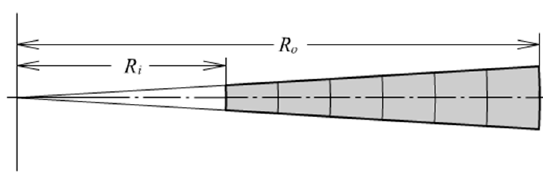
Figure 13. Internal pressure vs. radial expansion.